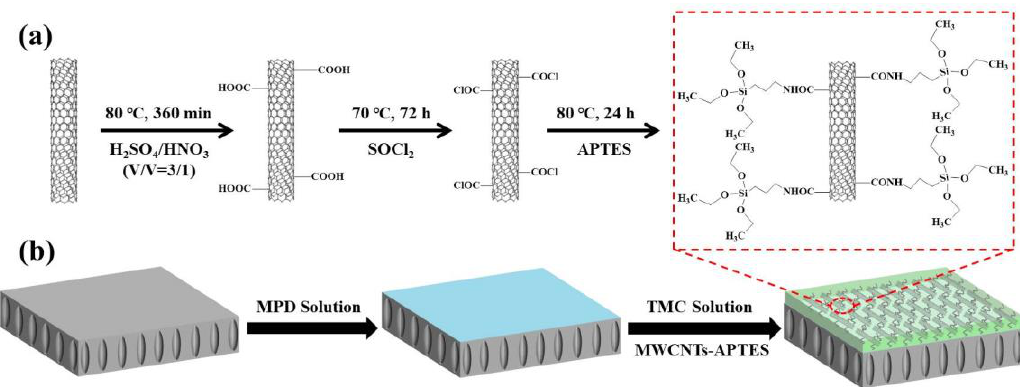
Figure 1. Schematic illustration of MWCNTs grafted with APTES ( a ) and TFN membrane synthesis ( b ).